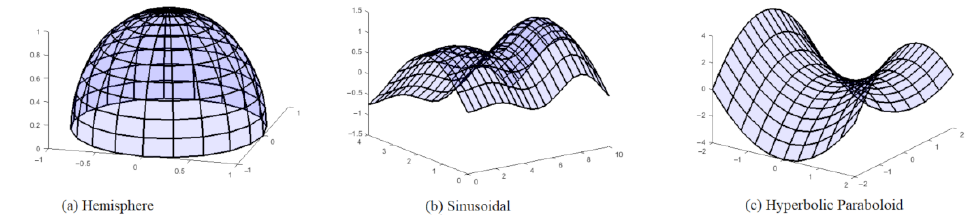
Figure 2. Three benchmark gridshells (quadrangular) with different Gaussian curvature taken from